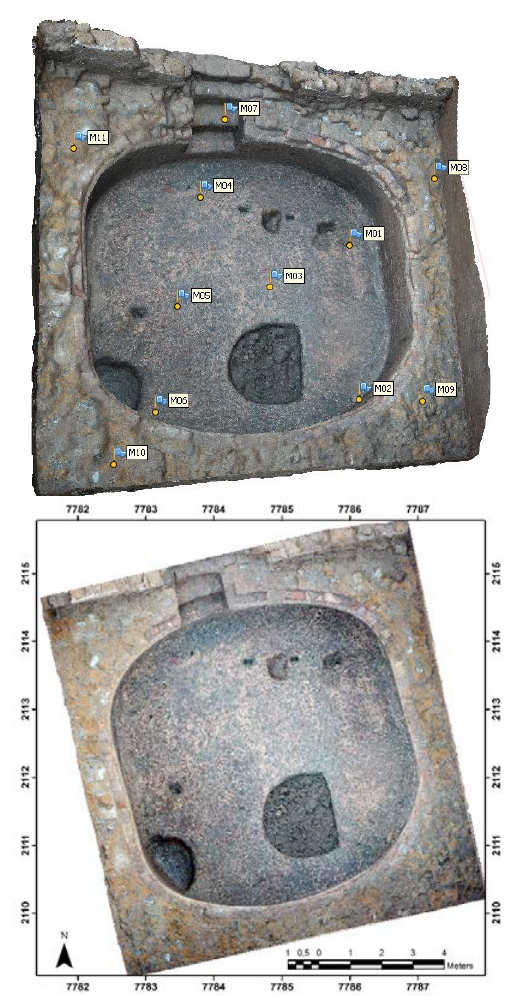
Figure 4. 2D and 3D models obtained by aerial survey and post- processing in SfM environment. a) 3D point cloud with indication of the markers b) Orthophoto of the archaeological artefact located in the excavation of “Duomo” metro station, in the city-center of Naples, Italy